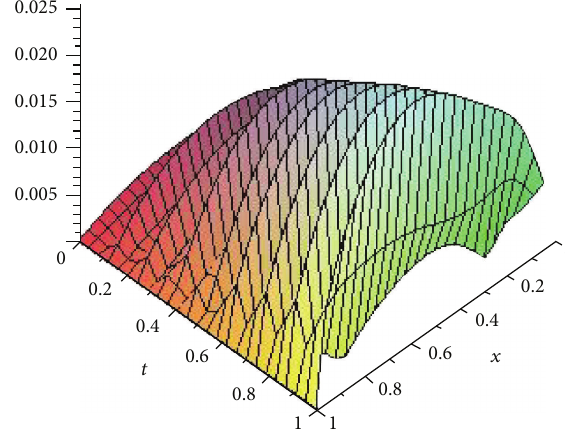
Figure 6: Plot of the absolute error 𝑒(𝑥, 𝑡) = |𝑦(𝑥,𝑡)−𝑦 𝑛,𝑘 (𝑥,𝑡)| with 𝑛 = 3, 𝑘 = 8 for Example 3.